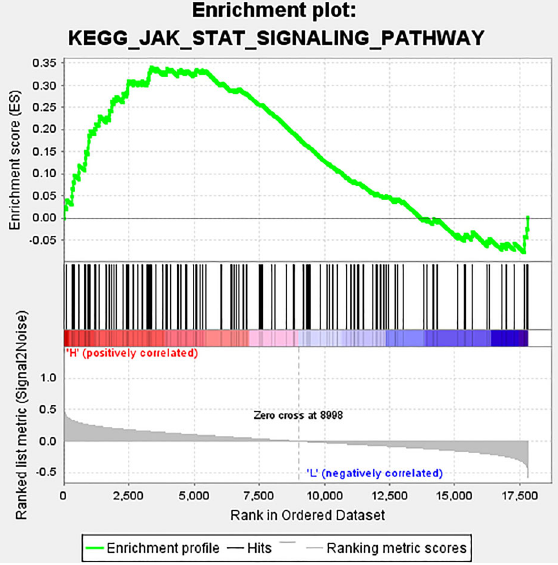
Figure 6. GSEA analysis was carried out to identify the pathways closely related to MARVELD1